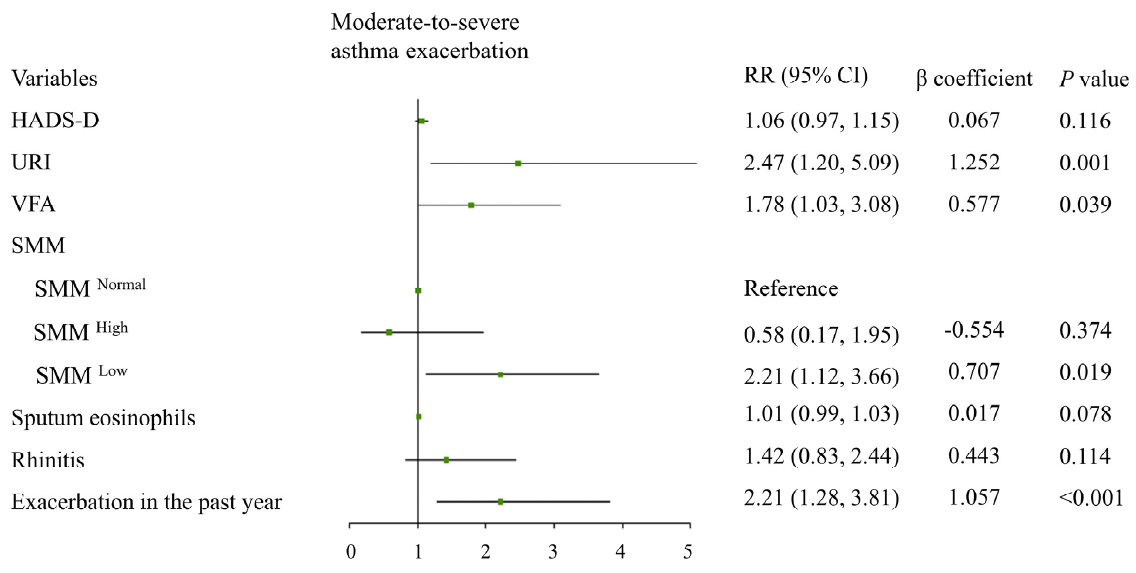
Figure 3. Risk factors in the prediction model for future moderate-to-severe exacerbation of asthma in the following years. Green dot, point estimate; Black line, 95% confidence interval.